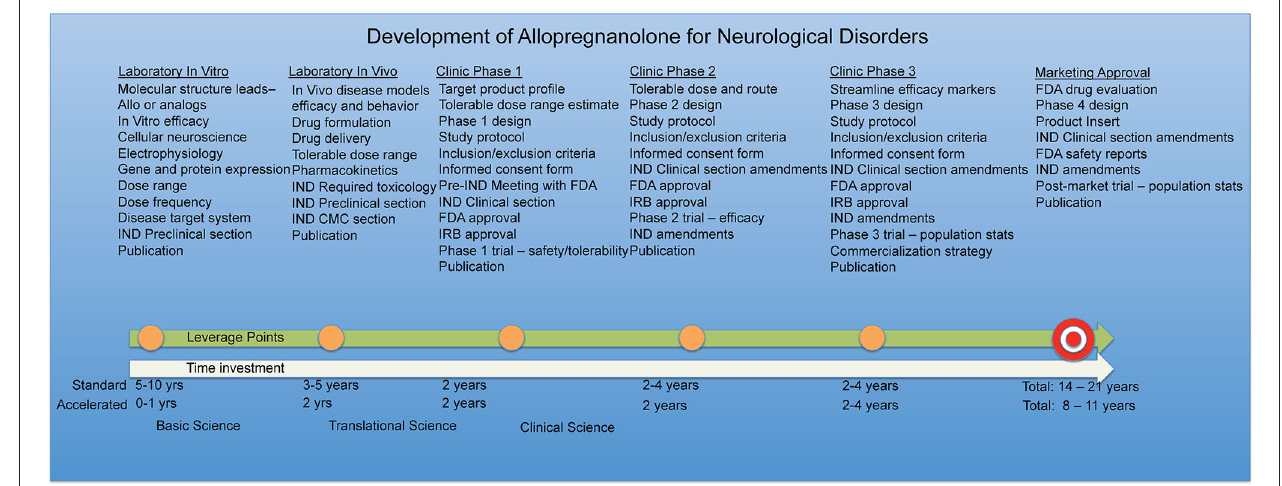
resources and information, it is plausible to accelerate therapeutic development timelines to 8 years or less, completing clinical trials more rapidly for unmet medical